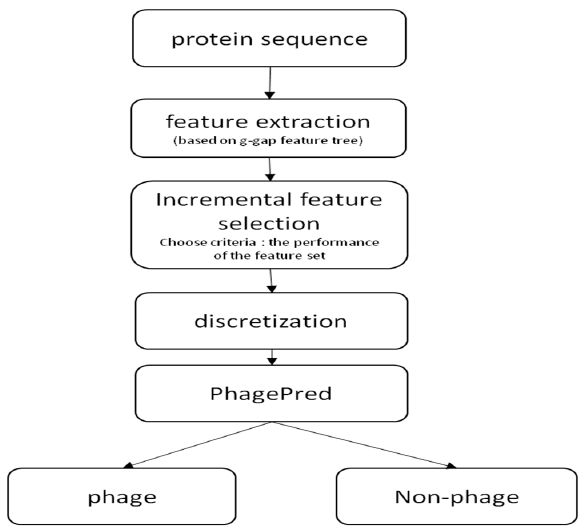
Figure 1. The computational framework of the PhagePred.